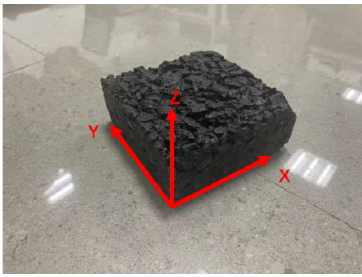
Figure 3. This is a figure. Schemes follow the same formatting.